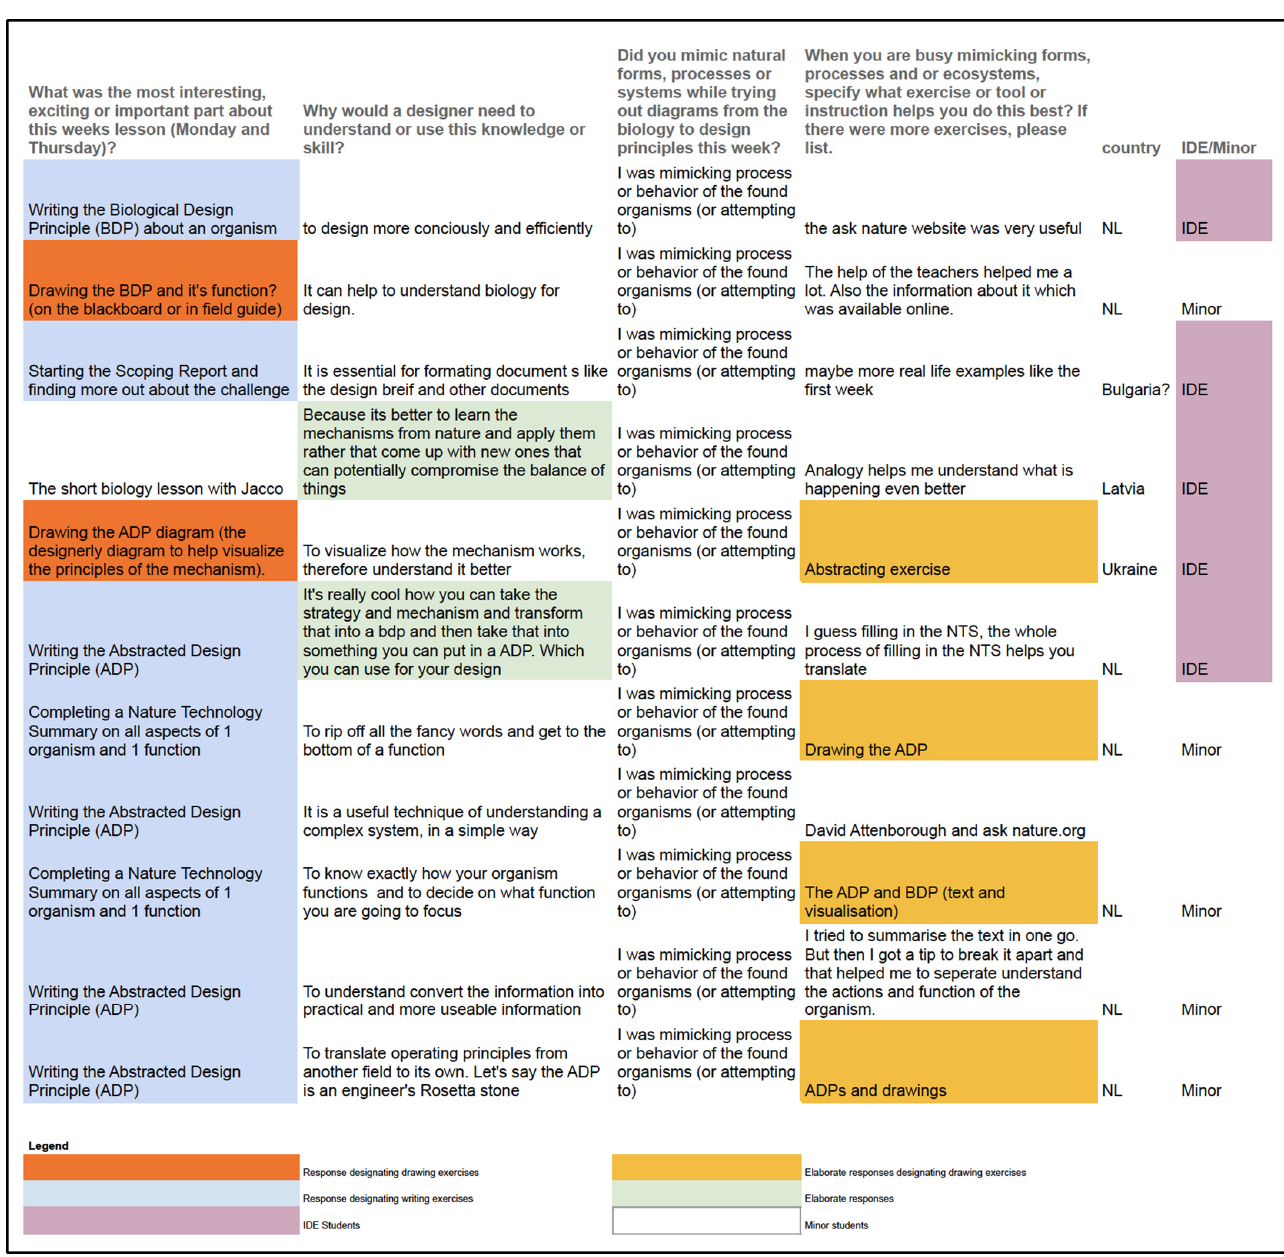
Figure 10. Interview responses of the student cohort mimicking process in their designs. (3) All who mimicked systems (six students) responded elaborately (Figure 11). The responses on importance of lesson material were evenly split between writing, drawing and “other” exercises in these six responses. All students responding that they felt they would need this skill than students mimicking form or process.